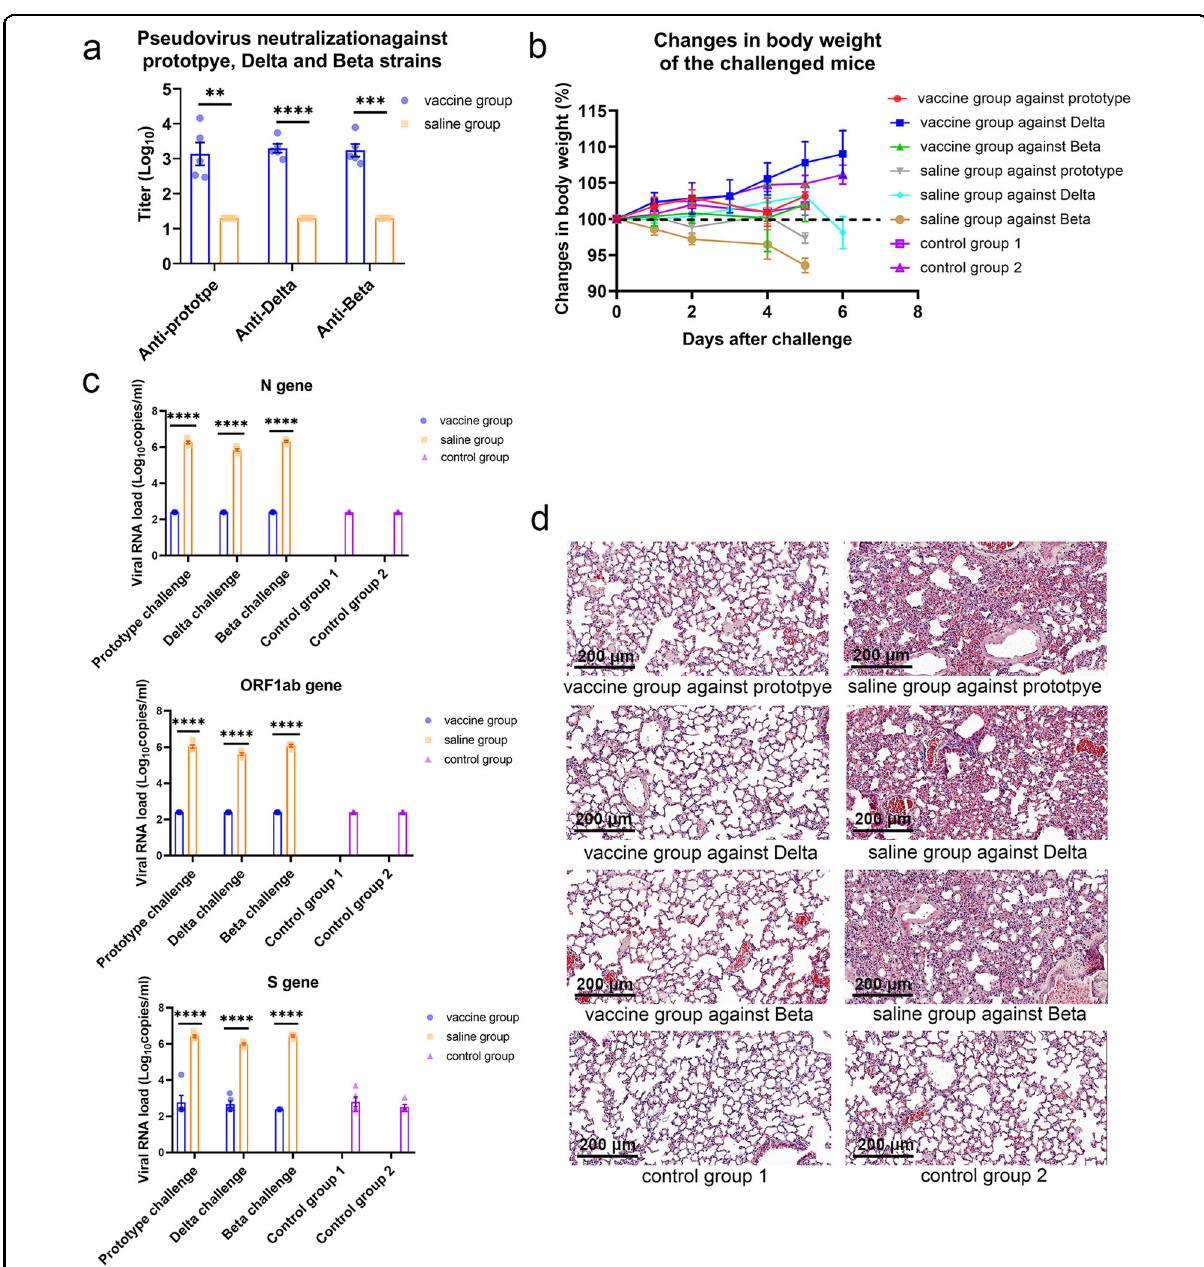
Fig. 5 Protective ef fi cacy of mutI-tri-RBD in hACE2-transgenic mice against challenge with the SARS-CoV-2 prototpye, Delta, and Beta strains, respectively. a The mice were immunized with two doses of mutI-tri-RBD with 2 µg/dose on Day 0 and Day 21, or injected with two doses of physiological saline as a control. On day 7 after the complete immunization, the sera from the caudal vein of the immunized mice were collected. The titers of pseudo-virus neutralizing antibodies in the sera of the immunized mice against the prototype, Delta and Beta SARS-CoV-2 strains, respectively, were measured for the vaccine groups and compared with those in the corresponding saline-treated groups. Data are presented as means ± SEM. P values were calculated with Student ’ s t- test. ** P < 0.01, *** P < 0.001, **** P < 0.0001. b On day 14 or day 19 after the complete immunization, the mice were challenged with the prototype, Delta and Beta live SARS-CoV-2 viruses (1.5× 10 5 TCID 50 ), respectively, and correspondingly control groups were challenged with saline (15 µL) as blank controls. The changes in the body weight of the mice were recorded during virus challenge experiments. Data are presented as means ± SEM. c The lung tissues were collected at 5 or 6 days after virus challenge. The viral load was measured by the copies of N, ORF1ab, and S genes. The viral load less than the detectable limit (<500 copies/ μ L) was set to half the value of the limit, i.e., 250 copies/mL. Data are presented as mean ± SEM. P values were calculated by using one-way ANOVA followed by Sidak ’ s multiple comparison test. **** P < 0.0001. d Histopathological examinations of the lung tissues of the mice. Scale bars, 200 μ m